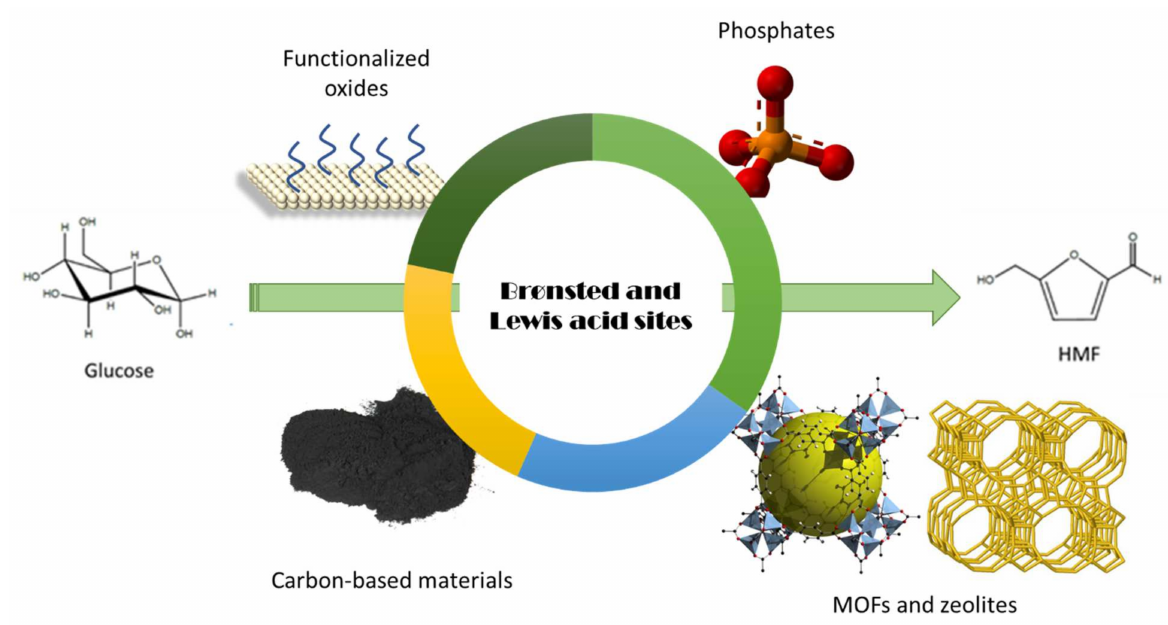
Figure 6. Involved sites and most studied catalysts for glucose conversion into